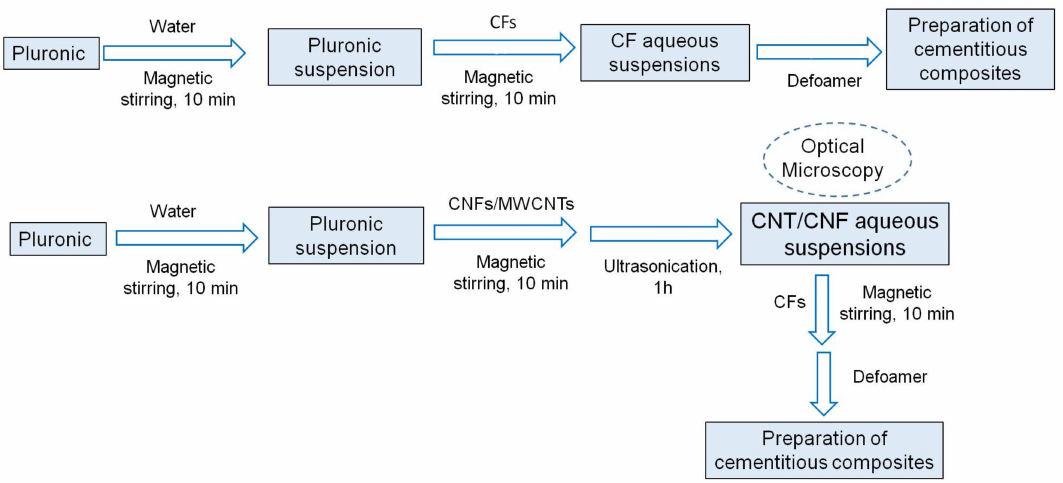
Figure 2. Schematic diagram showing the preparation of aqueous suspensions for fabrication of cementitious composites.